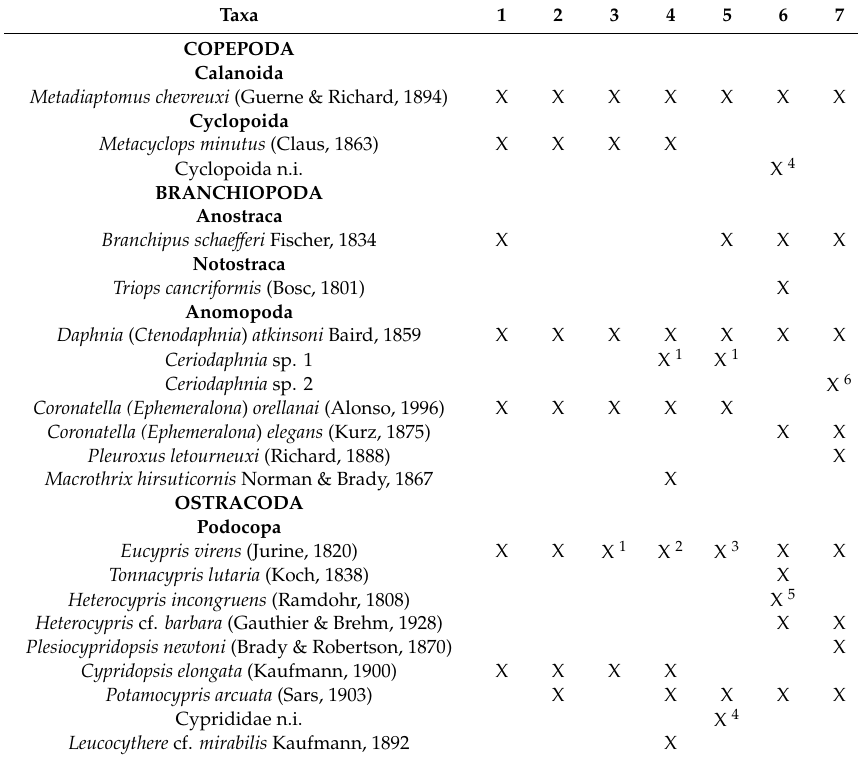
Table 2. Crustacean species list in Andalusian and Sicilian ponds at the sampling date. Sites 1: Blanca; 2: Caparid á n; 3: Sabinar; 4: Barjal í ; 5: Filabres; 6: Pozze dell’Ucceria; 7: Pozza di Grotta del Piano (see Figure 1).